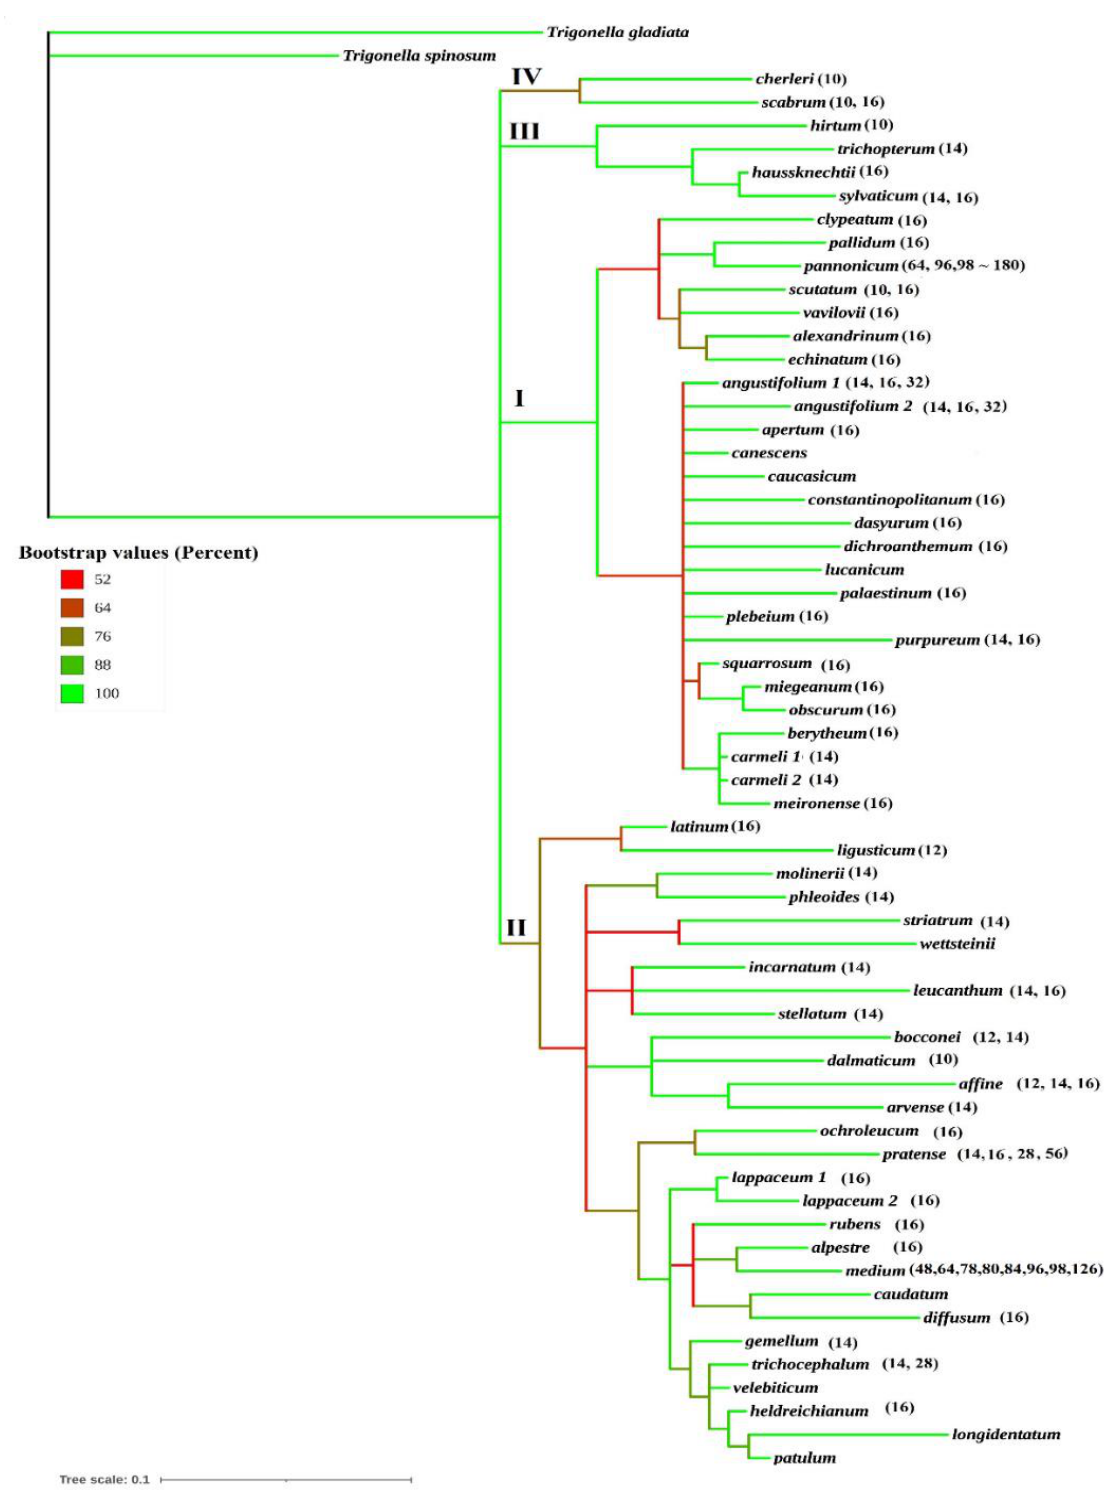
Figure 1. Phylogenetic tree expressing the classification of the species of the section Trifolium based on the ITS sequence and informative indels using MrBayes software and applying the Interactive Tree of Life (iTOL) tools. The colors of lines indicate the bootstrap value (percentage) for the separation of clades as expressed in the tree. The delimitation of the species as four clades is supported by a bootstrap value.